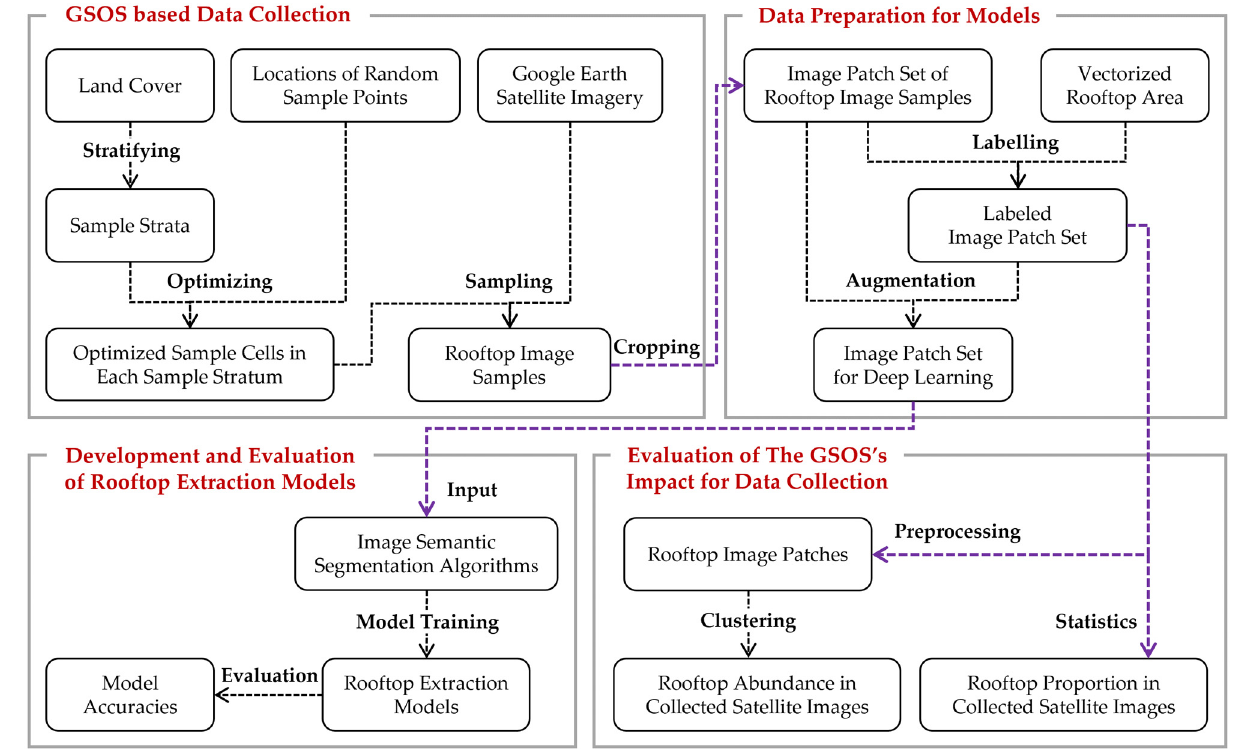
Figure 3. Overall working framework.